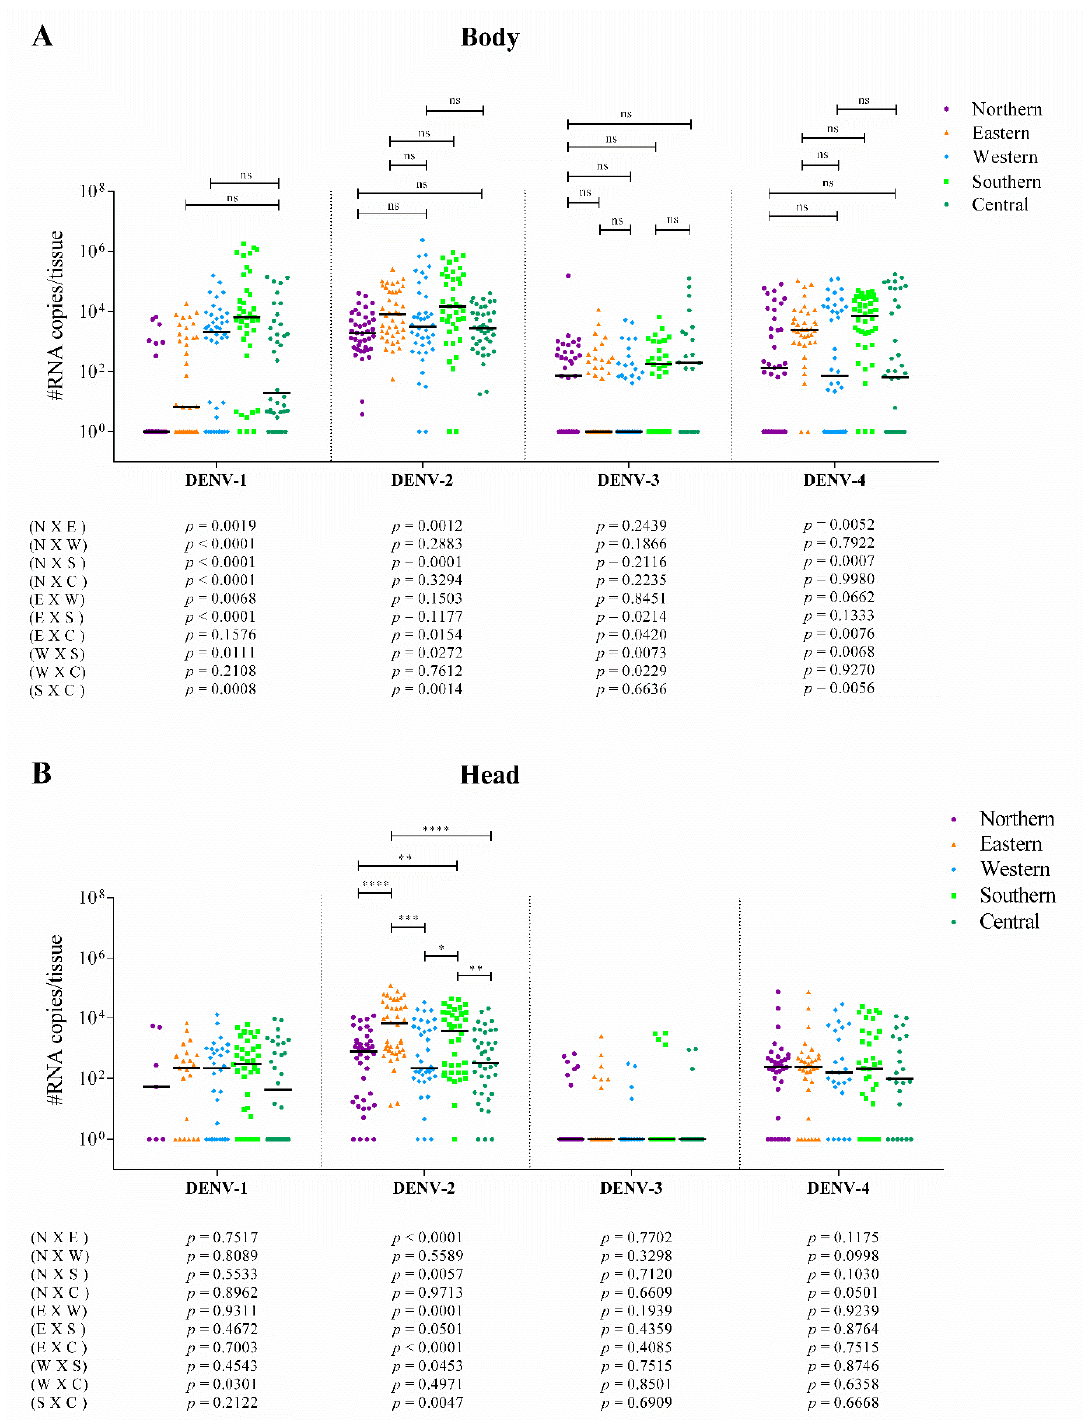
Figure 4. Interpopulation variability in the body ( A ) and head/SG ( B ) viral-load patterns of Ae. ae- gypti in the northern, southern, eastern, western, and central populations (different colored symbols). Each bar represents a median viral load in the data. In ( A ), we represent only the non-significant results (more results were statistically distinct) to simplify the demonstration and facilitate comparisons. In ( B ), we represent only the significant results. All p values were listed for the 10 possible comparisons among the mosquito populations to each DENV serotype. N = northern; E = eastern; W = western; S = southern; C = central. p values > 0.05 (non-significant) are represented as “ns”. p values ≤ 0.05, ≤ 0.01, ≤ 0.001, and ≤ 0.0001 are summarized with one (*), two (**), three (***), and four (****) asterisks,